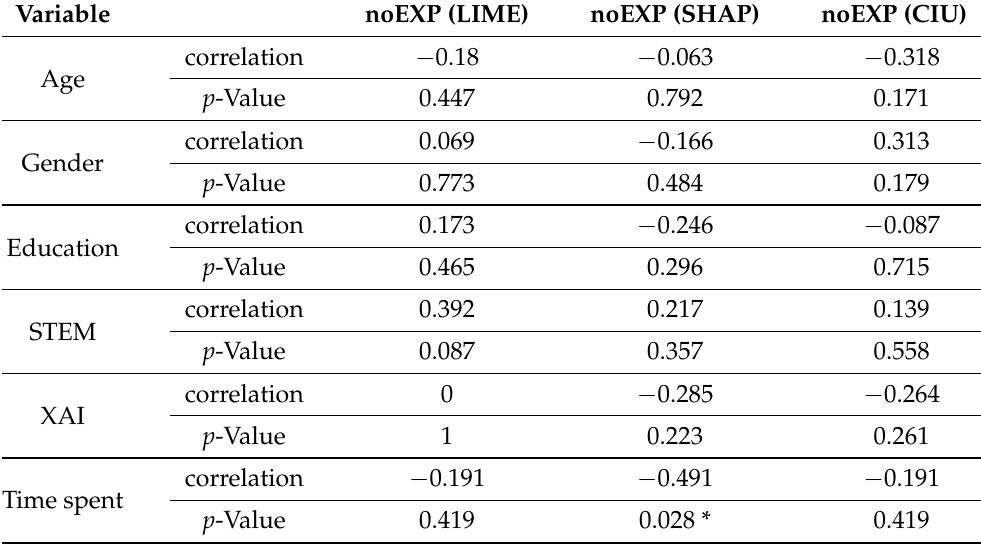
Table 15. Correlation between demographic variables and decision making in noEXP settings (note: * p < 0.05,